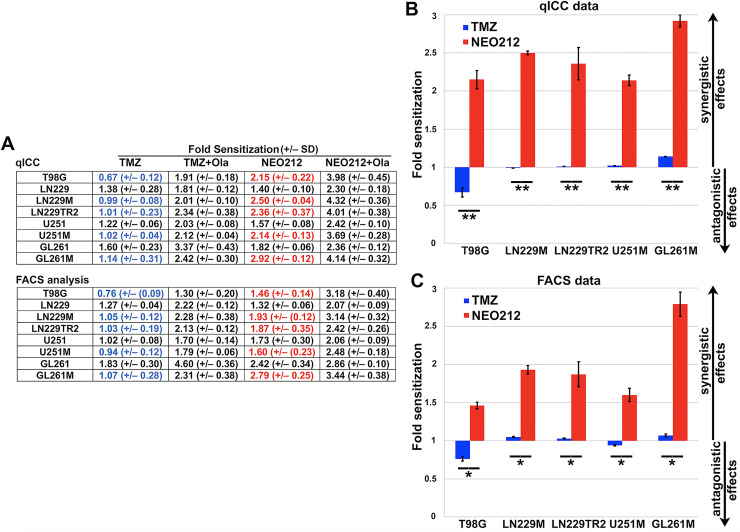
NEO212 is a robust radiosensitizer of TMZ-resistant GB cell lines.Fold sensitization values were determined from qICC and FACS datasets. Values >1 indicate synergistic effects (i.e., radiosensitization). Values equal to 1 indicate additive effects and values <1 indicate antagonistic effects. Panel A shows the tabulated fold sensitization data for TMZ and NEO212 either as monotherapies or in combination with Olaparib (Ola). While TMZ cannot sensitize MGMT-proficient or MMR-deficient cell lines to ionizing radiation (values in blue), NEO212 appears to consistently do so (values in red). The blue (TMZ) and red (NEO212) values for TMZ-resistant cell lines are graphed in Panels B and C. A low concentration of Olaparib (i.e., 10 nM) added to either TMZ or NEO212 further improve the radiosensitization profiles of both drugs. All values were found statistically significant (*signifies a p<0.01 while **signifies a p<0.001 as determined by ANOVA with Tukey post-hoc testing).